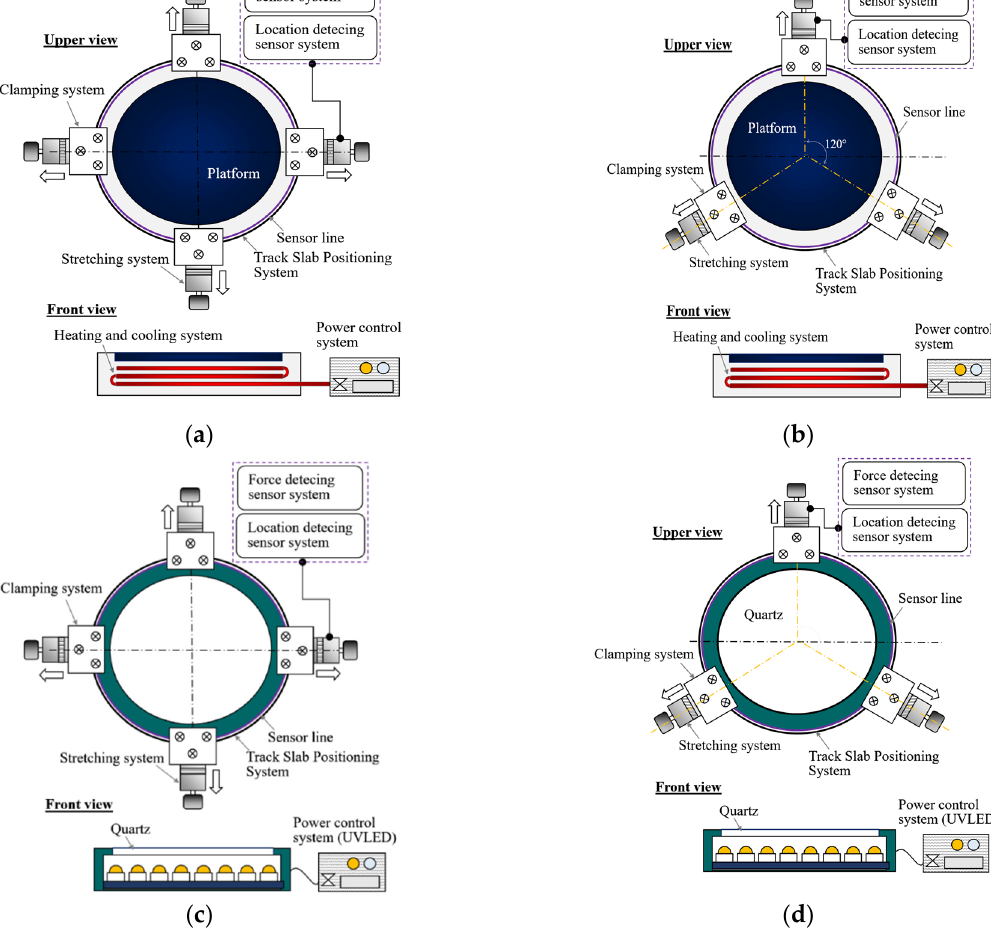
Figure 6. Multi-directional dynamic NPR mold clamping and P2P-forming system development ( a ) quadaxial NPR microstructure hot-embossing system; ( b ) triaxial NPR microstructure hot-embossing system; ( c ) quadaxial NPR UV-curing system; and ( d ) triaxial NPR UV-curing system.